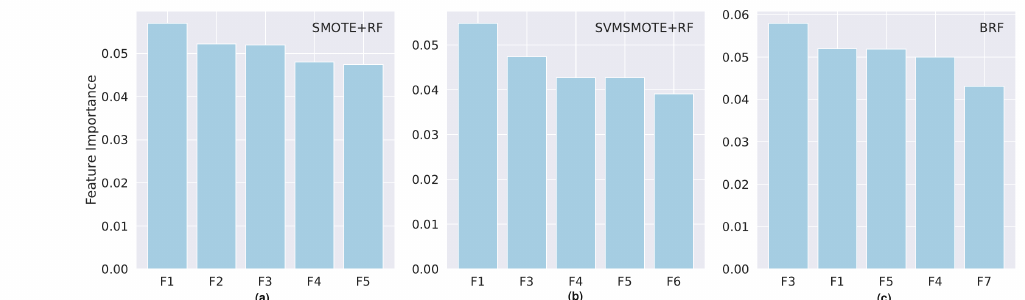
Figure 5. Top five most important features for models built with dataset S0 for the models with best scores: ( a ) SMOTE and Random Forest; ( b ) SVMSMOTE and Random Forest; ( c ) Balanced